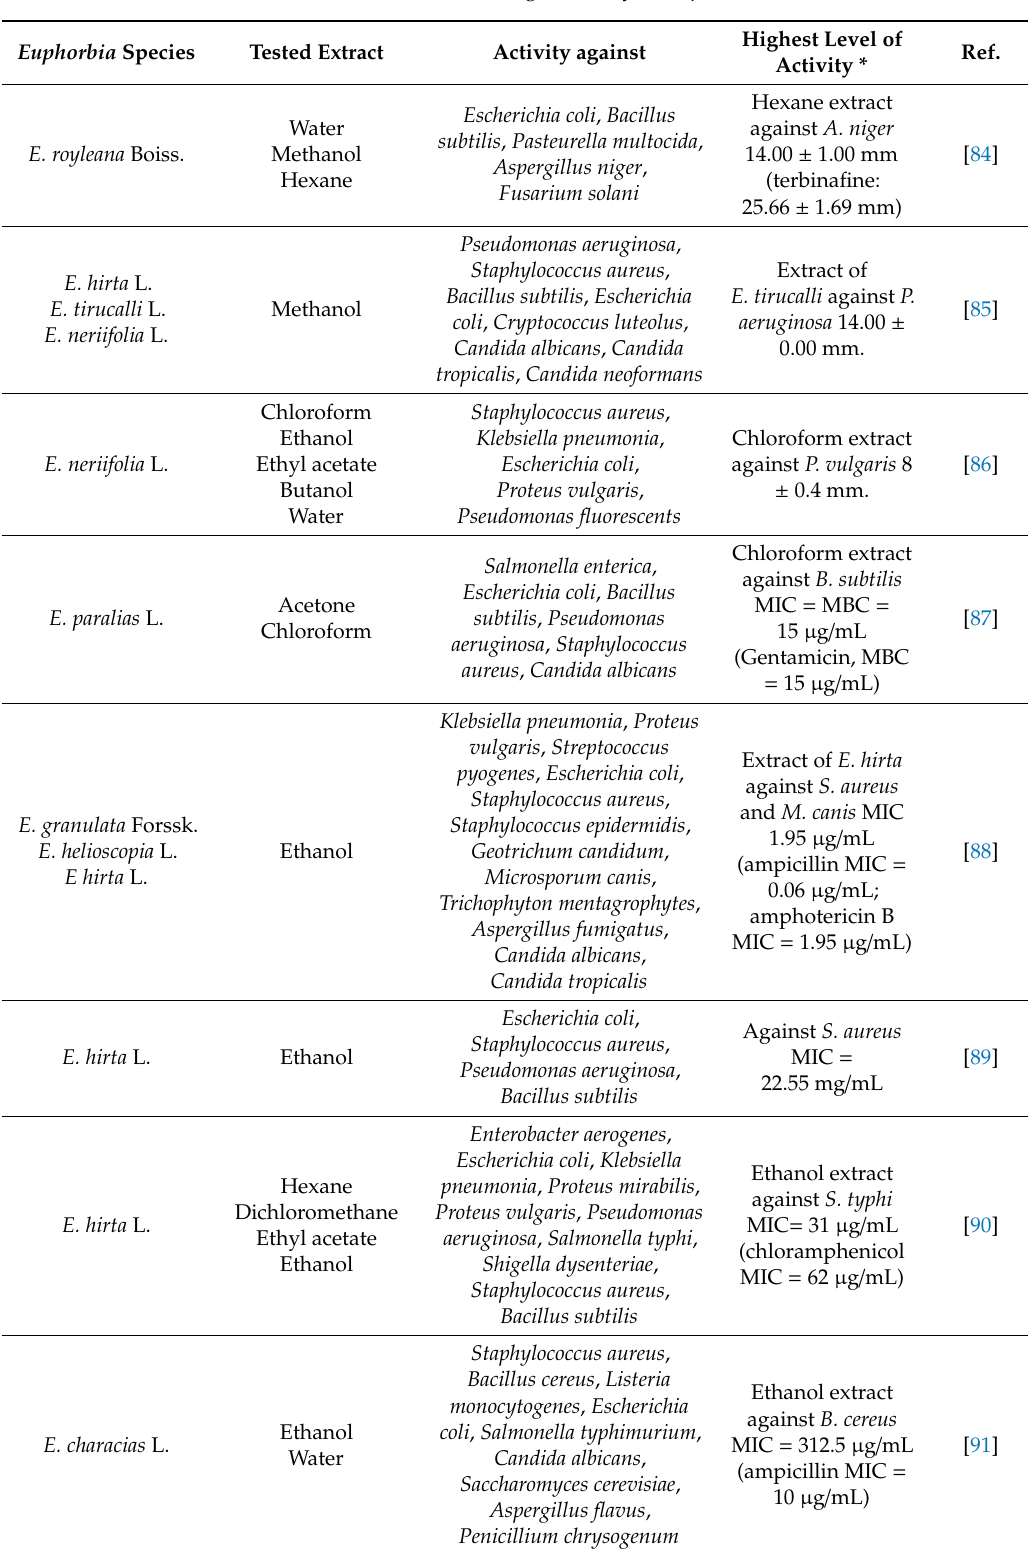
Table 2. Antibacterial and antifungal activity of Euphorbia extracts. Euphorbia